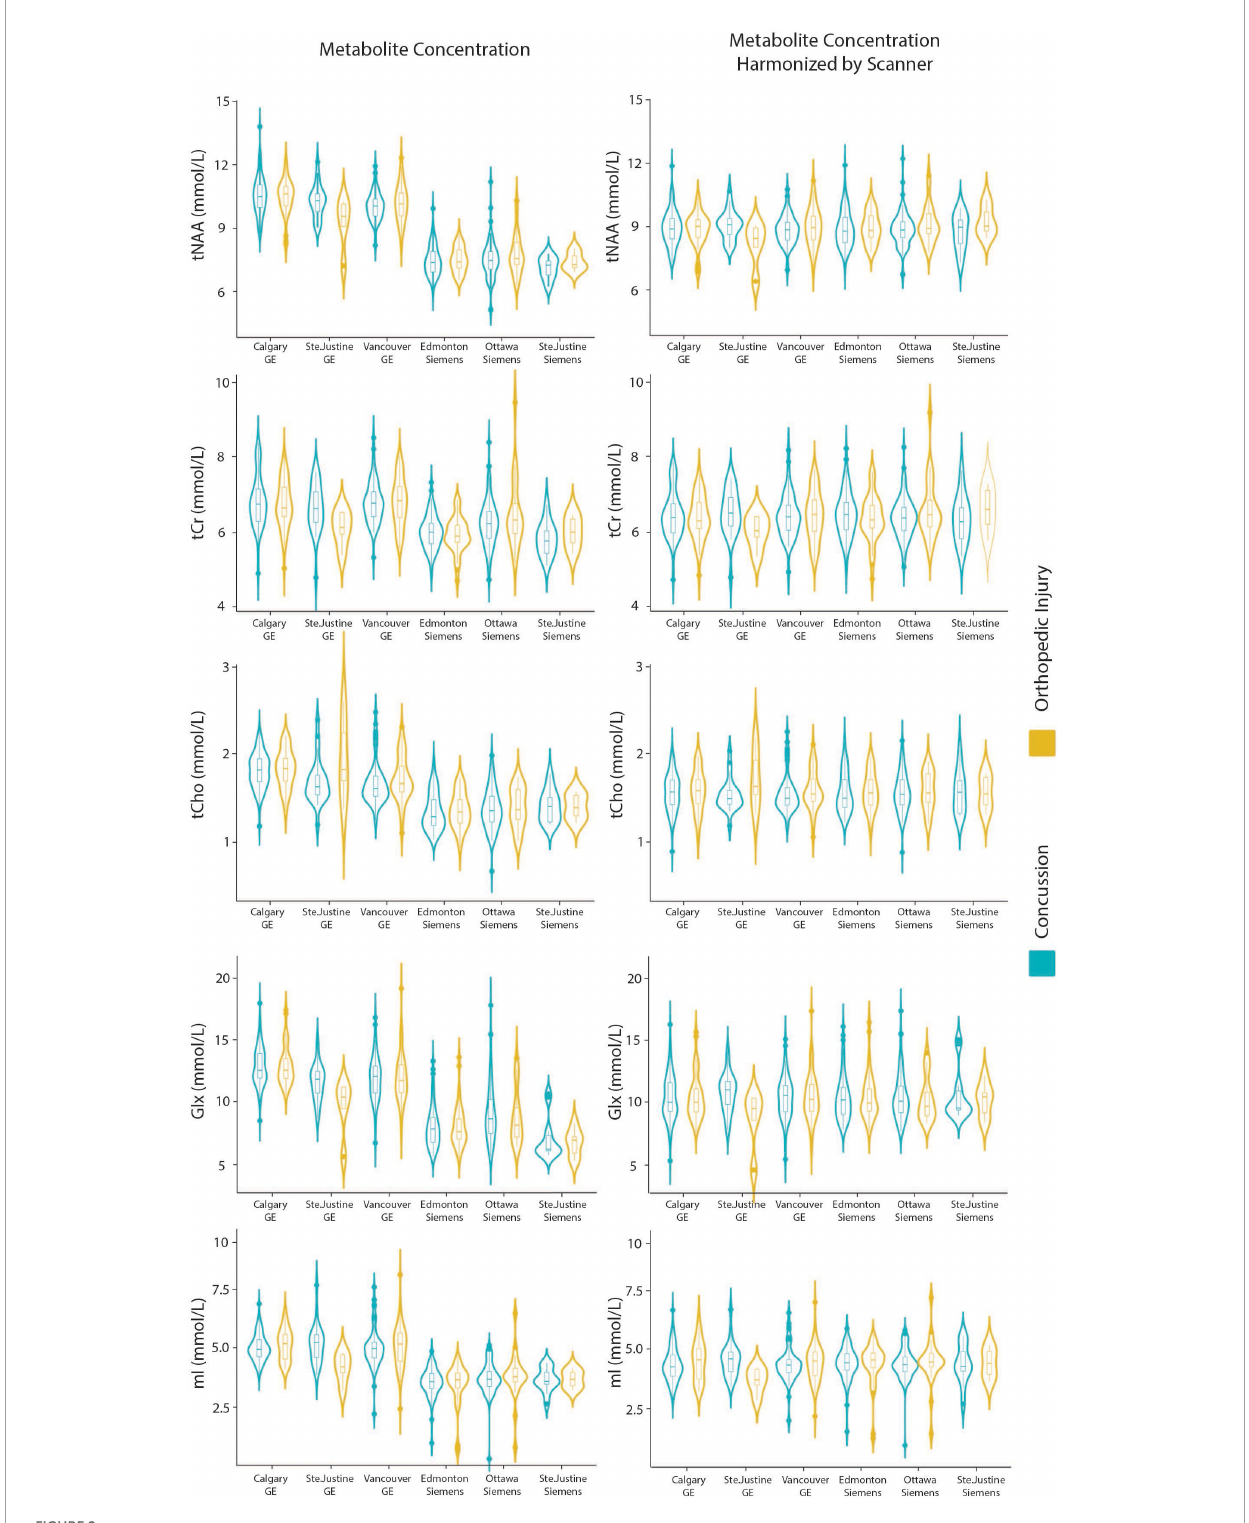
FIGURE2 Violin plots showin gmetabolite concentrations and data harmonized by the six different scanners for tNAA, tCr, tCho, Glx, and mI. The data are separated by the two clinical outcome groups: concussion and orthopedic injury.